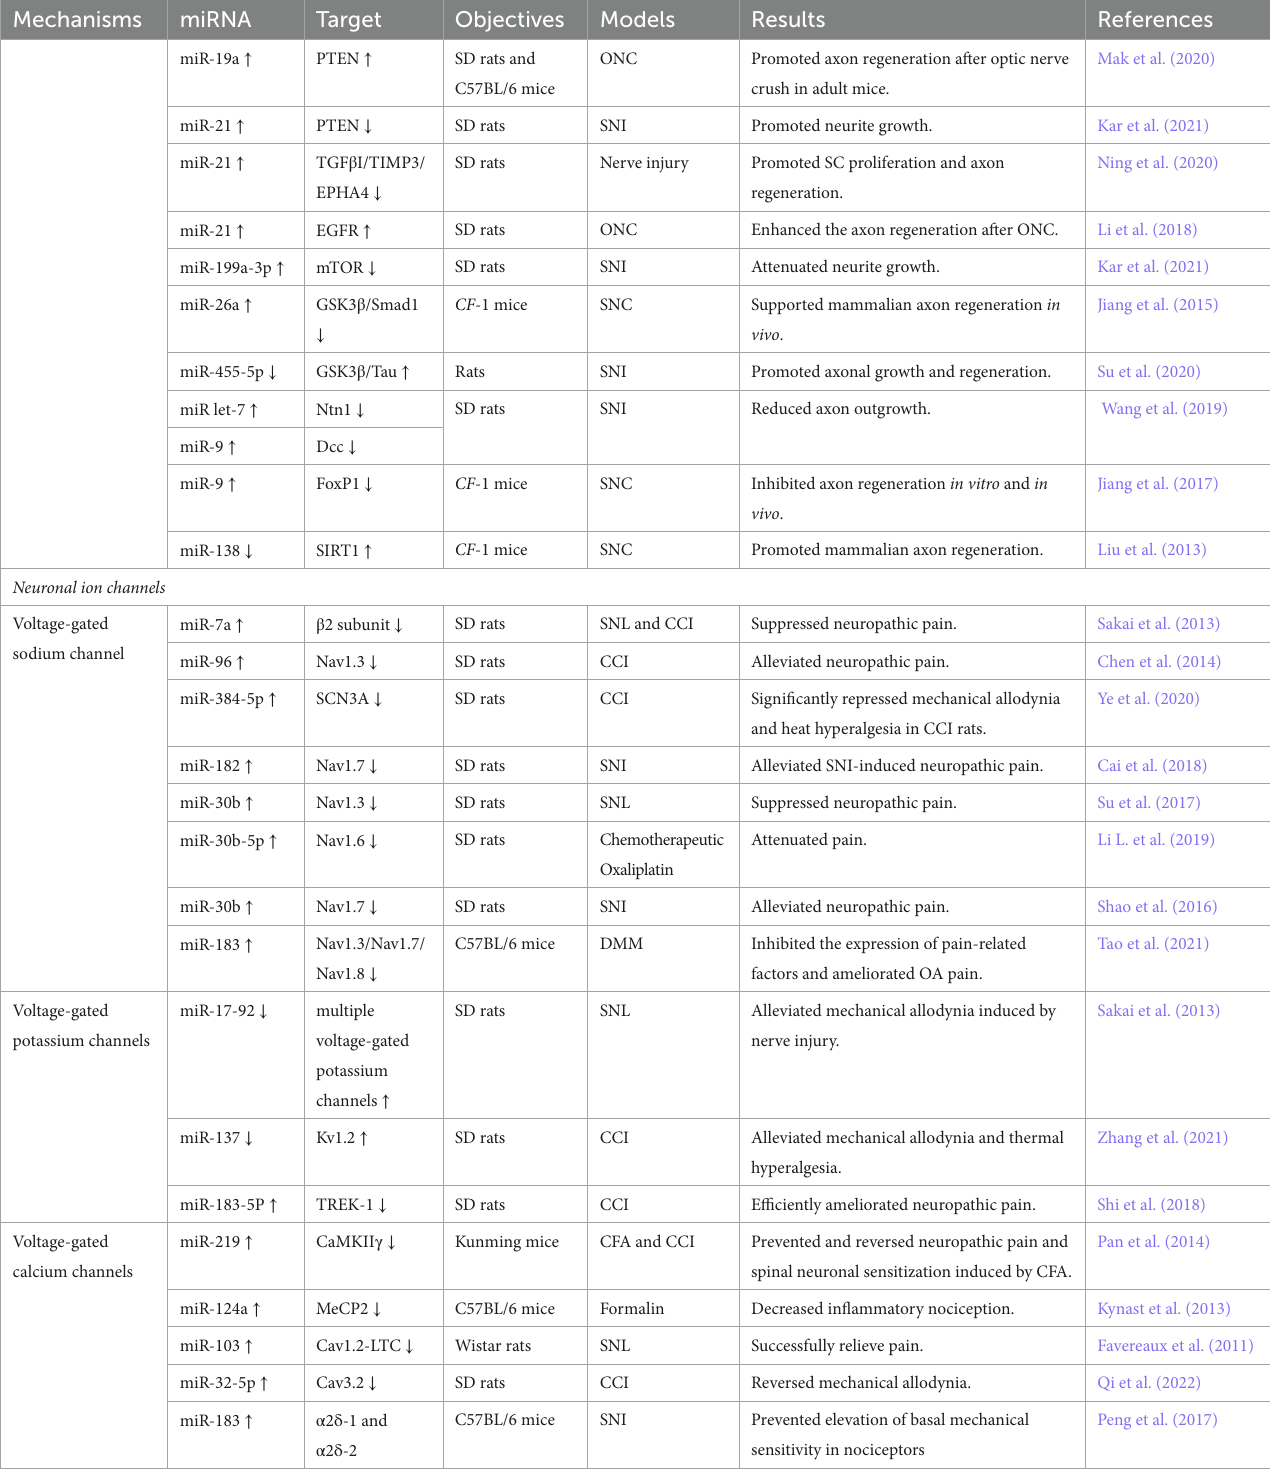
apoptosis protein; SNI, sciatic nerve injury; EFNA3, ephrin-A3; SNC, sciatic nerve crush; KLF4, kruppel-like factor 4; ONI, optic nerve injury; RGC, retinal ganglion cell; JAK, Janus kinase gene; STAT, signal transducer and activator of transcription; SCI, spinal cord injury; SPRR1A, small proline-rich repeat protein 1A; PTEN, phosphatase and tensin homolog; ONC, Optic nerve crush; TGF β I, transforming growth factor-beta-induced protein; TIMP3, tissue inhibitor of metalloproteinases 3; EPHA4, erythropoietin-producing human hepatocellular receptor A4; EGFR, epidermal growth factor receptor; mTOR, mechanistic target of rapamycin; GSK3 β , glycogen synthase kinase 3 β ; Ntn1, netrin-1; Dcc, deleted in colorectal cancer; FoxP1, forkhead box protein P1; SIRT1, Sirtuin 1; Nav, voltage-gated sodium channels; DMM, destabilization of the medial meniscus; Kv, voltage-gated potassium channels; TREK-1, TWIK-related K channel 1; MeCP2, Methyl-CpG binding protein 2; Cav1.2-LTC, Cav1.2-comprising L-type calcium channel; CaMKII, calmodulin (CaM)-activated kinase